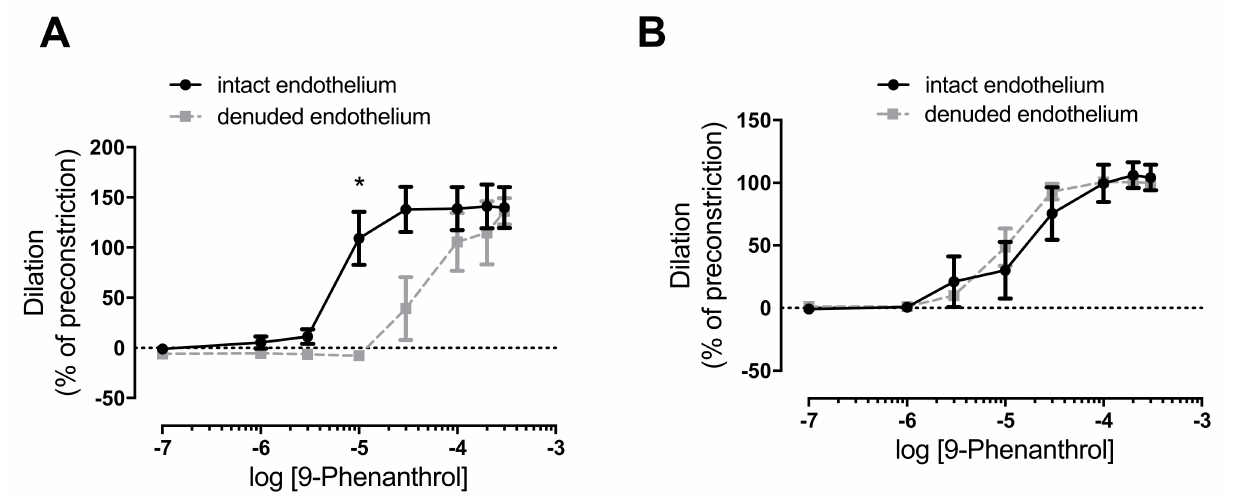
Figure 3. TRPM4 inhibitor 9-phenanthrol completely antagonizes norepinephrine (Panel A ) and KCl evoked vasoconstrictions (Panel B ), irrespectively of the endothelium. Pressure myography of rat skeletal muscle ( A ) and mesenteric arteries ( B ) was performed. Endothelium was removed via intra- luminal perfusion of air and distilled water (denuded endothelium). Vessels were preconstricted with 10 µ M norepinephrine; then, 9-phenanthrol was added in the indicated concentrations. Significant difference is indicated by the asterisk (*, p < 0.05, Sidak’s multiple comparison) vs. dilation in arteries with intact endothelium. Mean ± SEM are plotted on the graphs. Five ( n = 5) rats were used for the